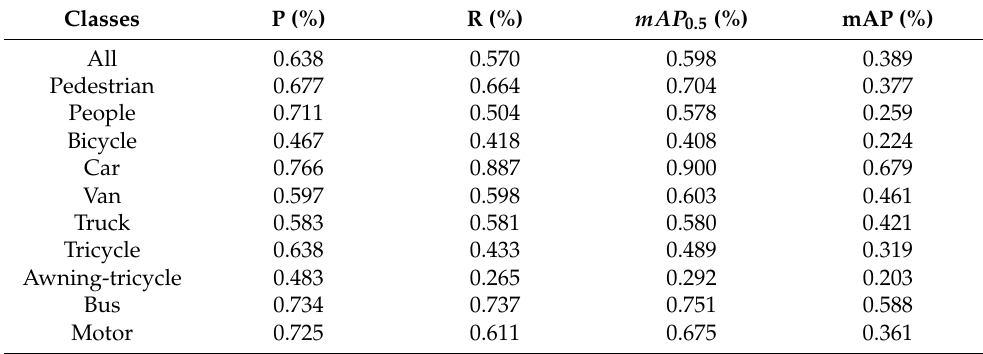
Figure 11. Confusion matrix for our method with the number of epochs during training and validation. Table 2. Model performance comparison on each of the individual